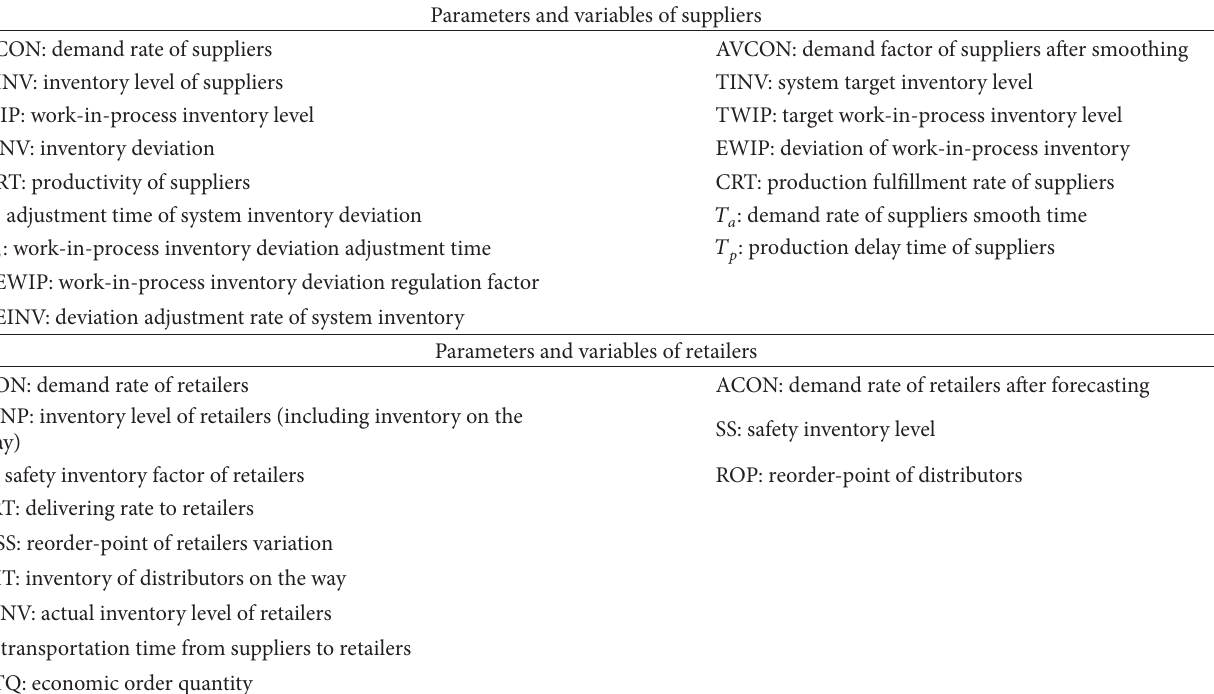
Table 2: Definitions of parameters and